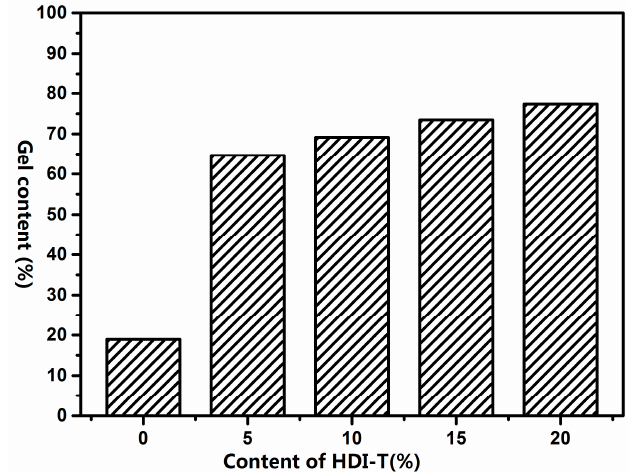
Figure 13. Gel contents of SPU films.